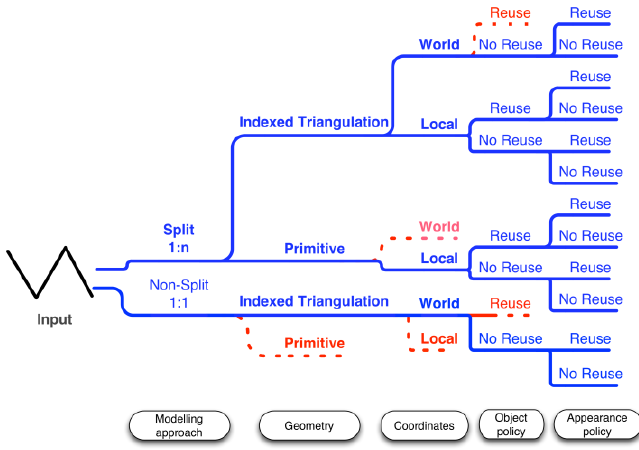
Figure 2: Possible reconstruction